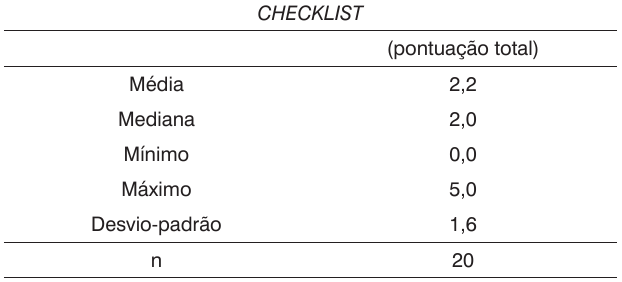
Tabela 3. Medidas descritivas do checklist de sinais e sintomas de